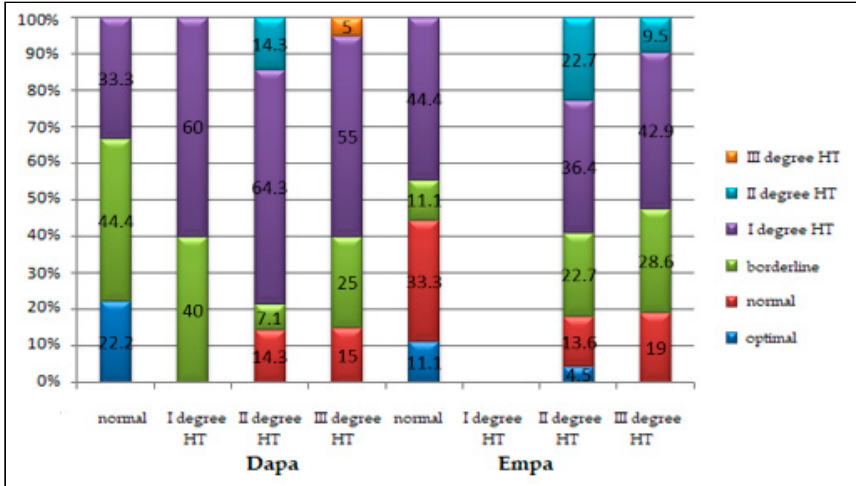
Figure 5. Correlation of BP values measured at the study entry with comparative staging by study groups.